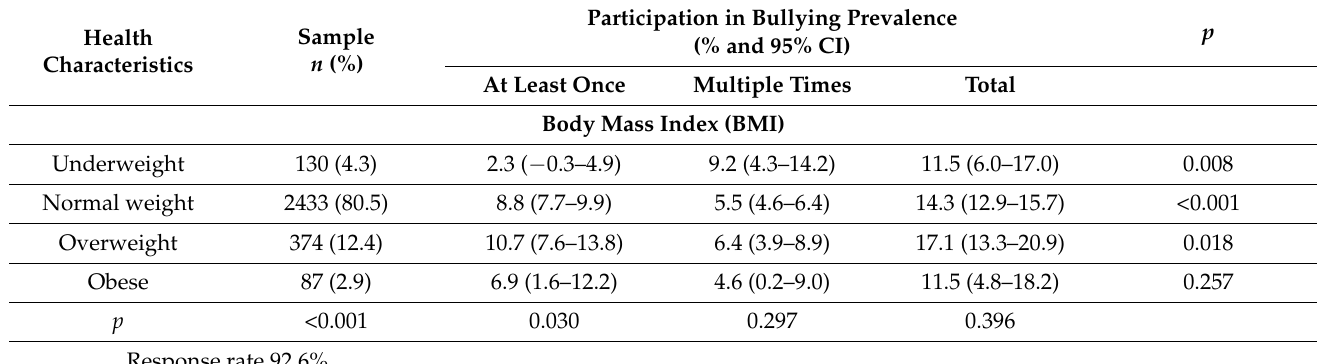
Table 1. Prevalence of bullying among school-age children and their health characteristics, Serbia,